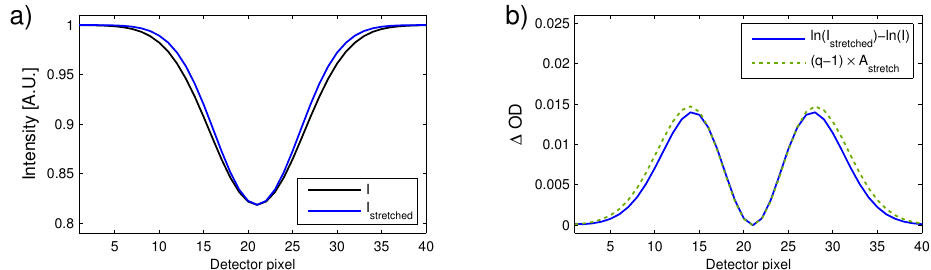
Fig. 2. Illustration of the effect of a spectral stretch of I . (a) Original (black) and stretched (blue) Intensity I in artificial units, showing a single absorption line according to Eq. (7), with an optical depth of a = 0 . 2 and a width ς of 5 pixel, for a stretch of q = 1 . 1. (b) Actual difference of the true and stretched OD (blue), compared to the linear approximation, i.e., the pseudo-absorber A Stretch as defined in Eq. (15), scaled by the applied stretch q − 1